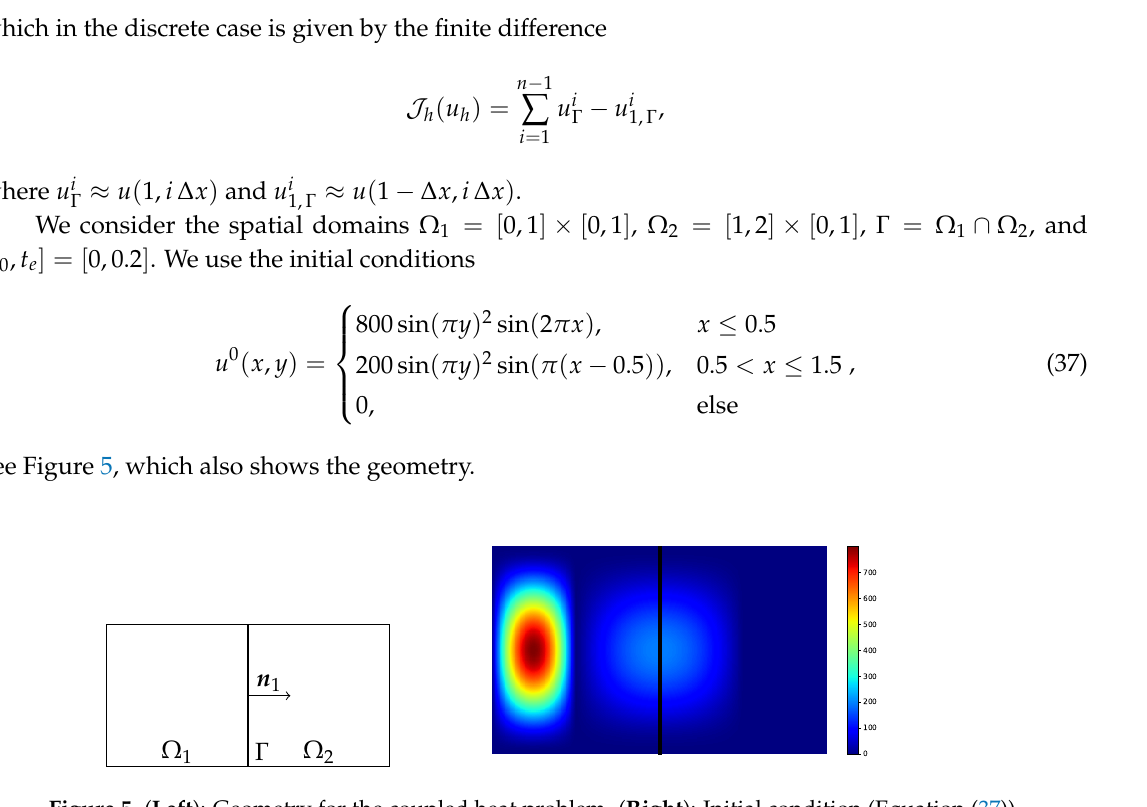
Figure 5. ( Left ): Geometry for the coupled heat problem. ( Right ): Initial condition (Equation (37)). For time-integration we use SDIRK2, which is implicit with ( p , ˆ p ) = ( 2, 1 ) . To solve the problem arising from the so called transmission conditions (Equation (36)) on the interface Γ , we use the Dirichlet–Neumann iteration for each stage derivative of SDIRK2 [29]. We choose the parameters α 1 = 0.1, λ 1 = 0.01 and α 2 = λ 2 = 1. Based on the results of [30], this gives us a convergence rate of approximately α 1 / α 2 = 0.1 for the Dirichlet–Neumann iteration for ∆ t → 0. Standard linear FE are used in space for both domains with identical triangular meshes for ∆ x = 1/81. Details of the implementation of the discretization and methods can be found in [31]. For this problem, we use ∆ t 0 = τ . The reference solution is computed using the classical scheme with τ = 10 − 6 and an absolute tolerance of 10 − 12 in the Dirichlet–Neumann iteration, where the numerical tests use an absolute tolerance of τ